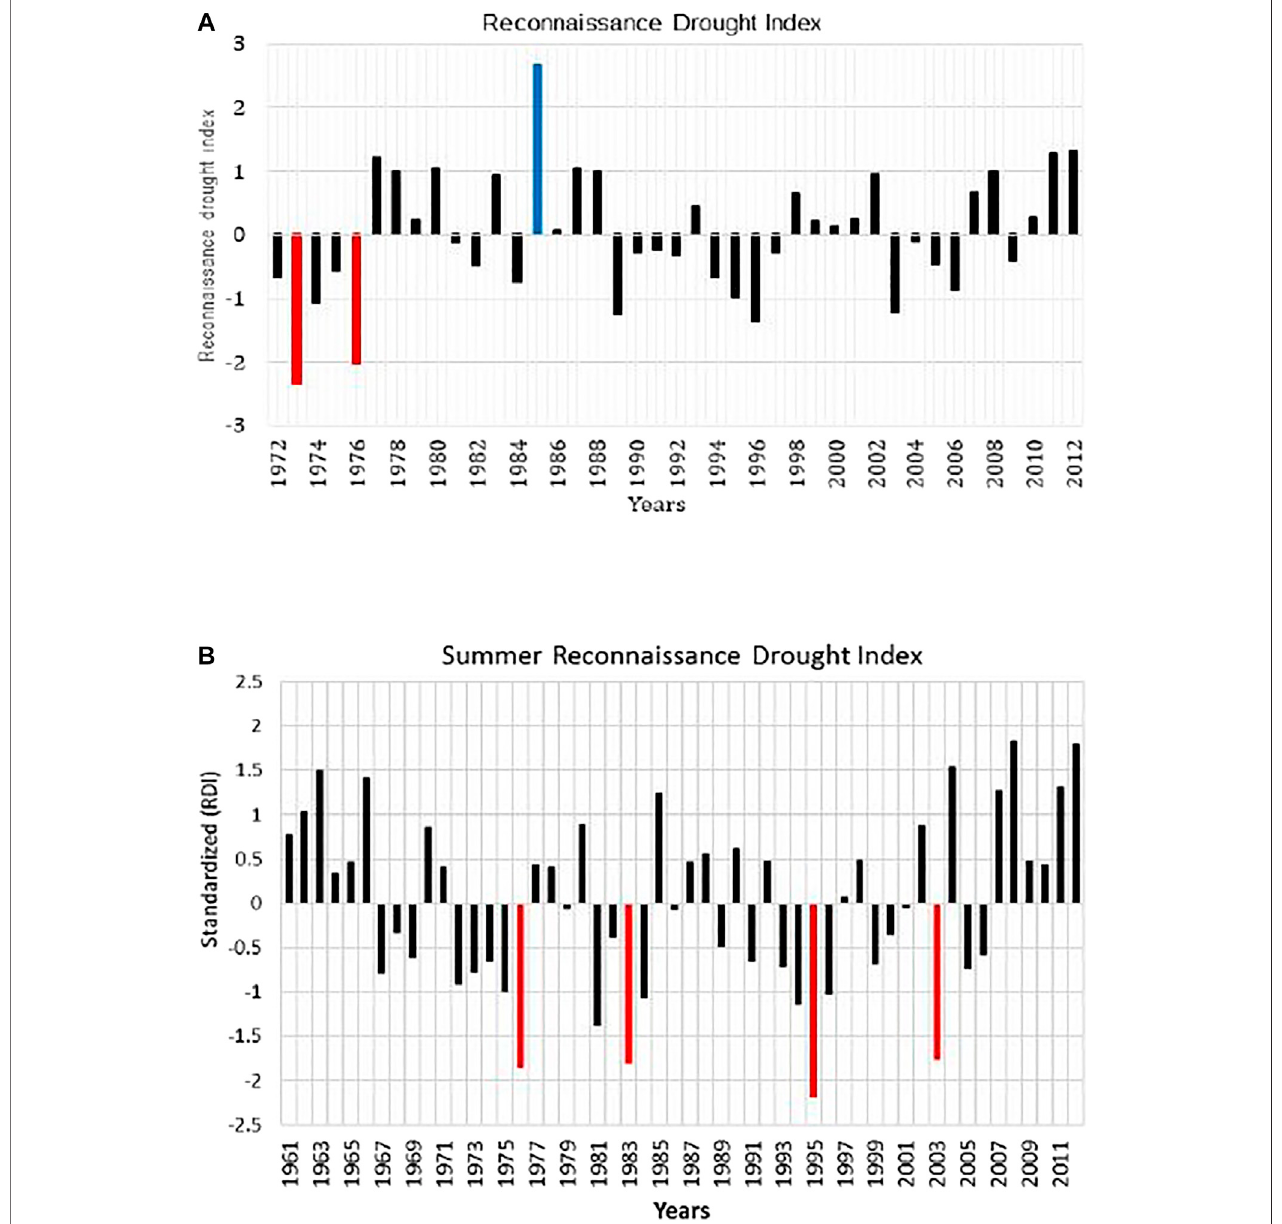
FIGURE 5 | (A) Annual reconnaissance drought index calculated using the potential evapotranspiration with gross rainfall (RDI); (B) Summer reconnaissance drought index calculated using the potential evapotranspiration with gross rainfall (Summer RDI). For both plots, the blue/red bars represent extreme wet and extreme dry